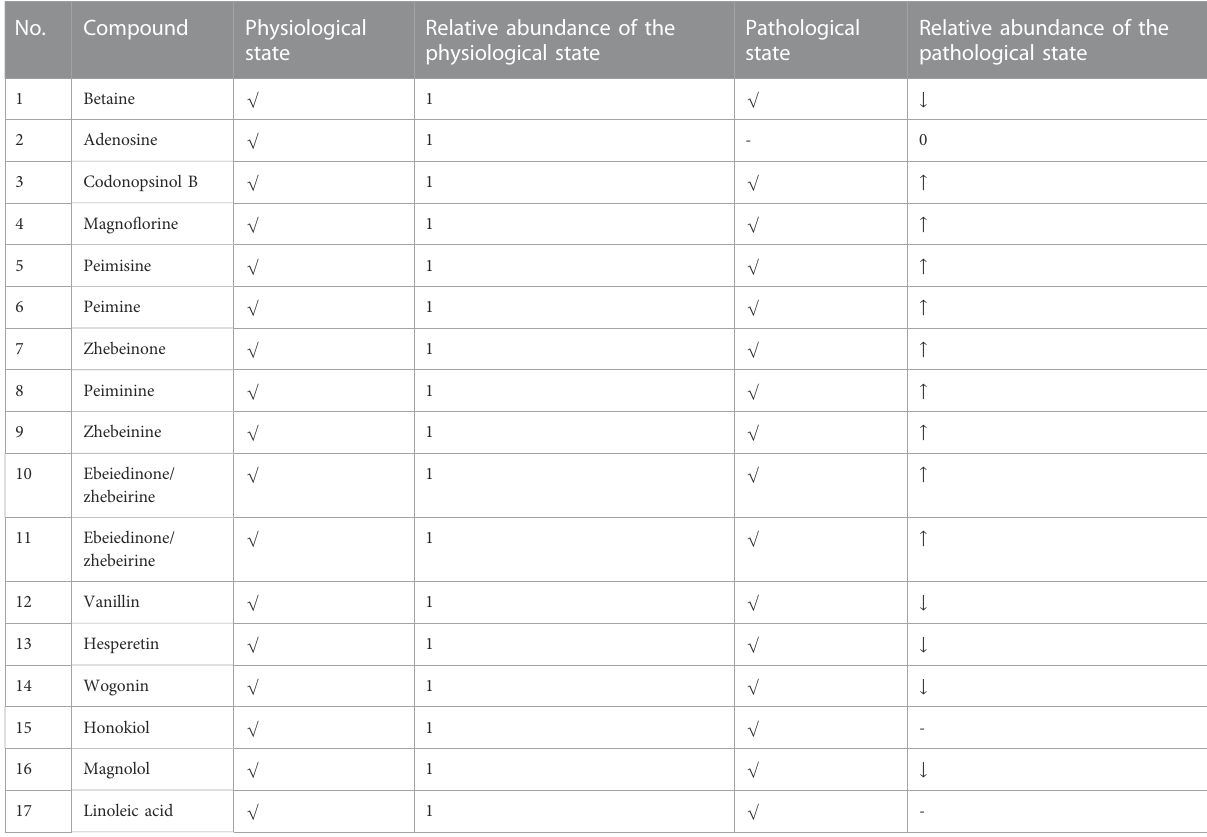
TABLE 2 Difference of prototype blood components.